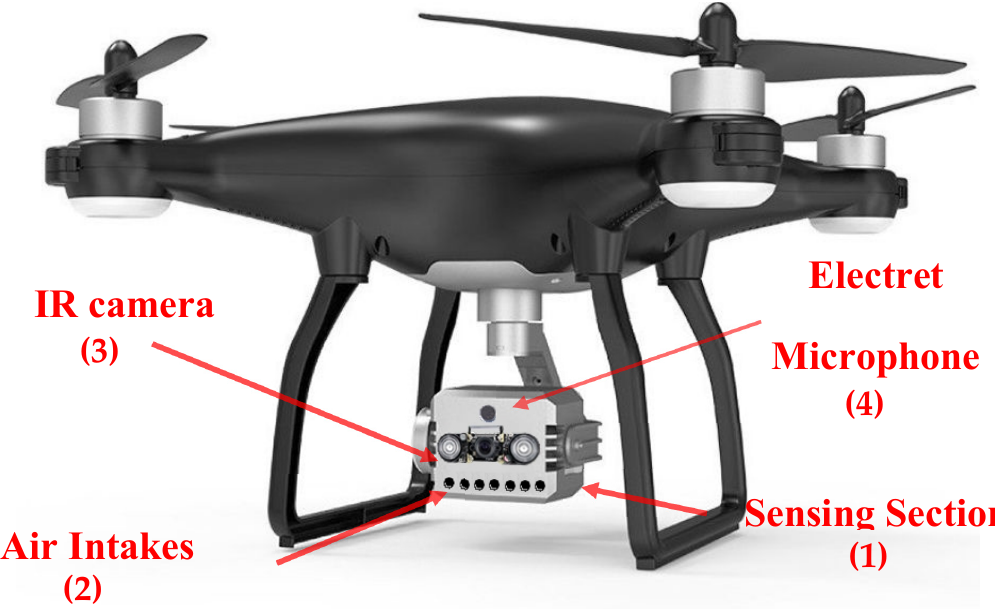
Figure 1. 3D image of the proposed mobile monitoring system.